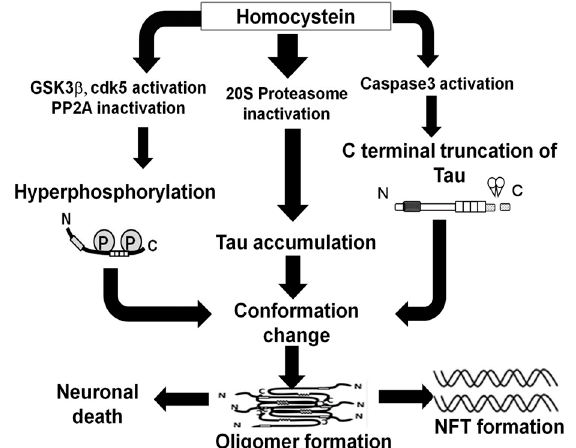
Figure 13. Schematic of expected effects of tau aggregation induced by homocysteine (Hcy). Hcy decreased 20S proteasome activity and tau accumulation in the cell. Hcy increased phosphorylation levels of tau protein via GSK3 β and cdk5 activation or PP2A inactivation. Hcy activates caspase 3 and